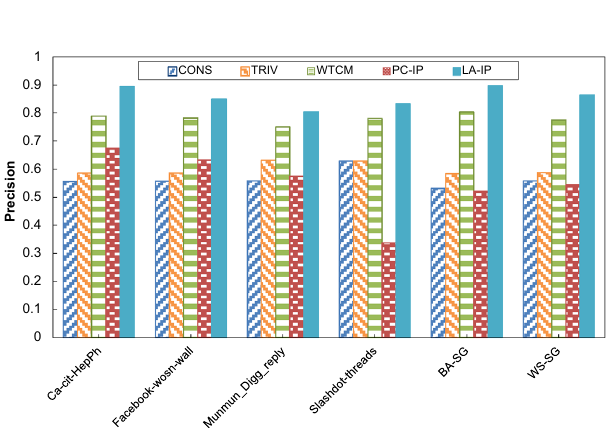
Figure 4. The results of the algorithms for the prediction of influence probabilities with respect to